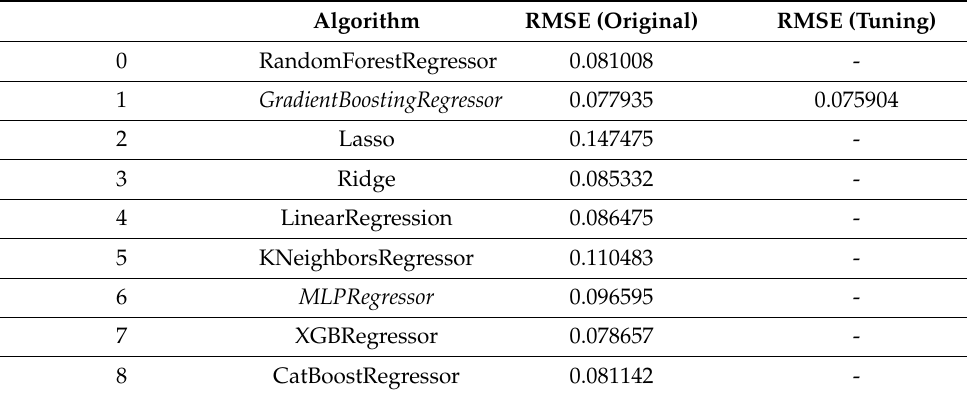
Table 8. RMSE Comparison results for the nine algorithms.